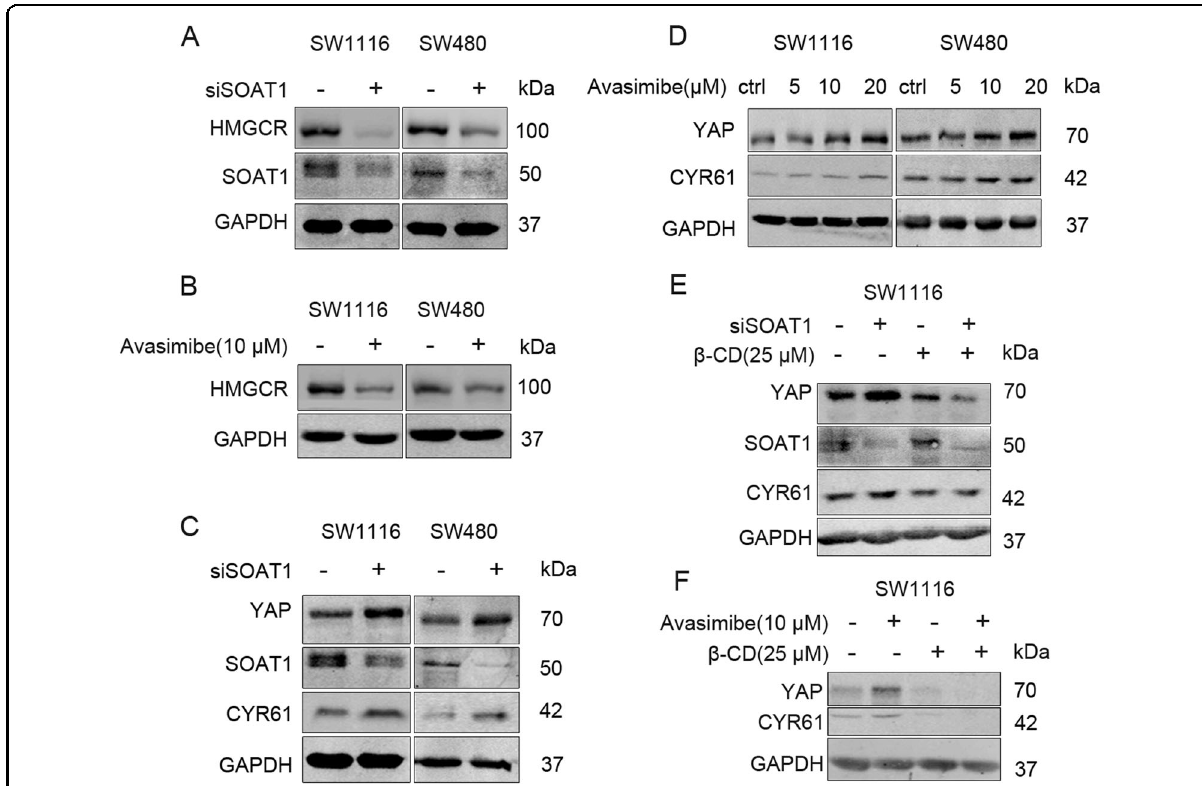
Fig. 2 Targeting SOAT1 regulates YAP in a cholesterol-dependent manner in colon cancer cells. A SW1116 and SW480 cells were transfected with control siRNA or siSOAT1 for 72 h, respectively. B SW1116 and SW480 were incubated with DMSO or avasimibe (10 μ M) for 24 h. C SW1116 and SW480 were transfected with negative control siRNA or SOAT1 siRNA for 48 h, respectively. D SW1116 and SW480 cells were treated with different concentration of avasimibe (5 – 20 μ M) for 16 h. E SW1116 were transfected with negative control or SOAT1 siRNA for 48 h, and then treated with β -cyclodextrin (25 μ M) for 4 h. F SW1116 cells were treated with DMSO or avasimibe (10 μ M) for 12 h, and then β -cyclodextrin (25 μ M) was incubated for 4 h. The expressions of HMGCR, YAP, and CYR61 were detected by Western